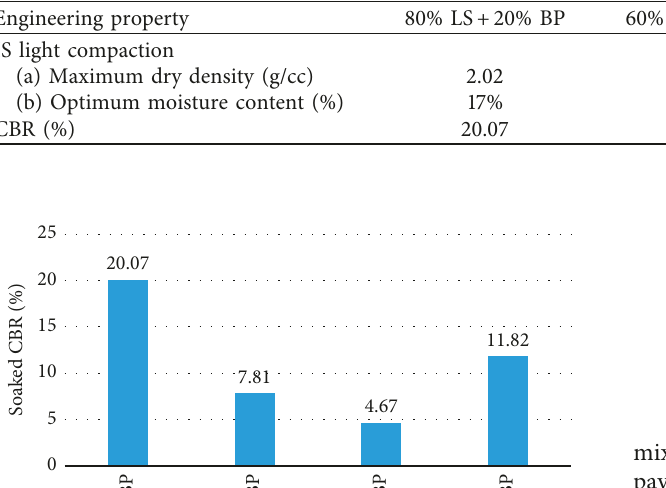
Table 4: Engineering properties of brick powder and lime-stabilized black cotton soil mixture. Engineering property